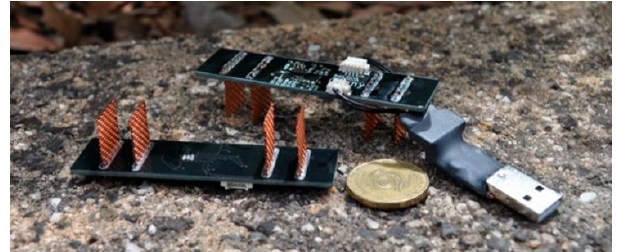
Figure 1. Examples of sensors for determining CR. А four-electrode sensor with USB connection: the external electrodes are designed to generate electric current, and the internal ones are to register the potential difference [41].